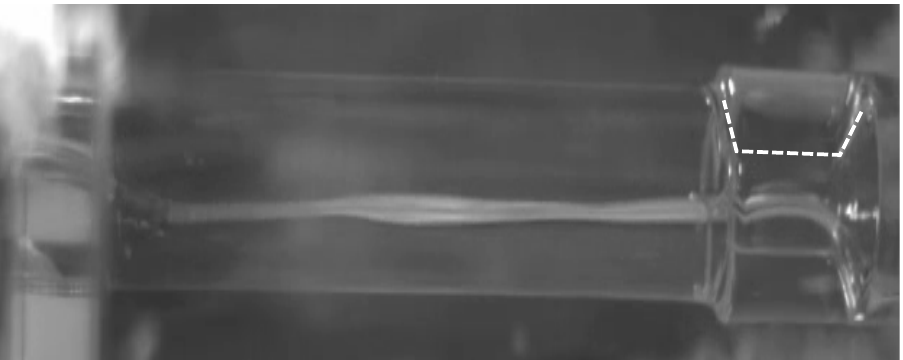
Figure 14. Slug flow upstream of the orifice.